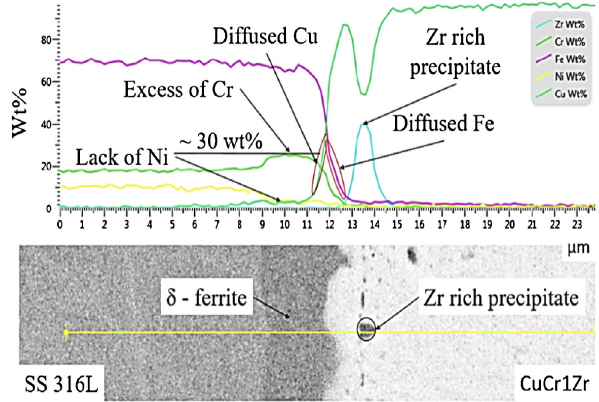
FIG. 8. EDX elemental linescans acquired at 20 keV accel- erating voltage in a direction perpendicular to the interface in order to assess the diffusion phenomena. The x axis represents in μ m the yellow line at the bottom of the picture, and the y axis gives the concentration of the chemical elements along this line. On the SS 316L side, there is a clear excess of Cr up to 30 wt % and a lack of Ni with some diffused Cu. On the CuCr1Zr side, it can be distinguished a peak corresponding to a Zr inclusion and some diffused